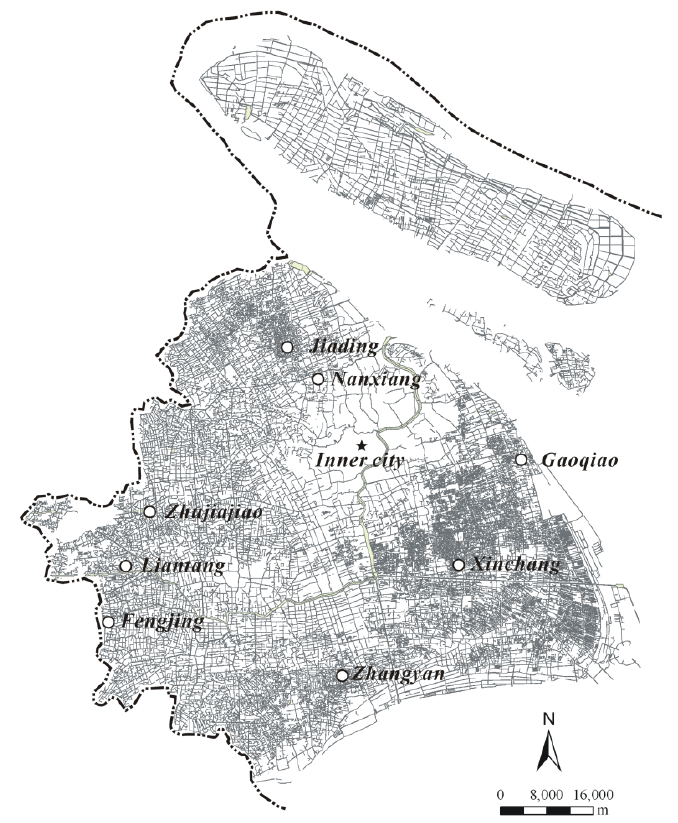
Figure 1. River network in Shanghai and sampling